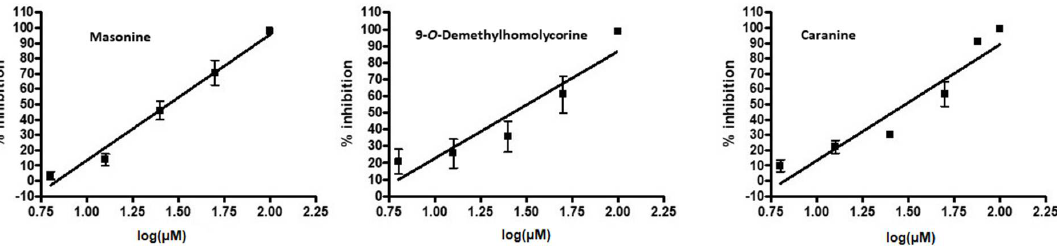
Figure 2. Linear graph of IC 50 assay of GSK-3 β treated with selected Amaryllidaceae alkaloids. Concentrations of alkaloids were 6.25; 12.5; 25; 50 and 100 µ M. Activity is presented as % inhibition.